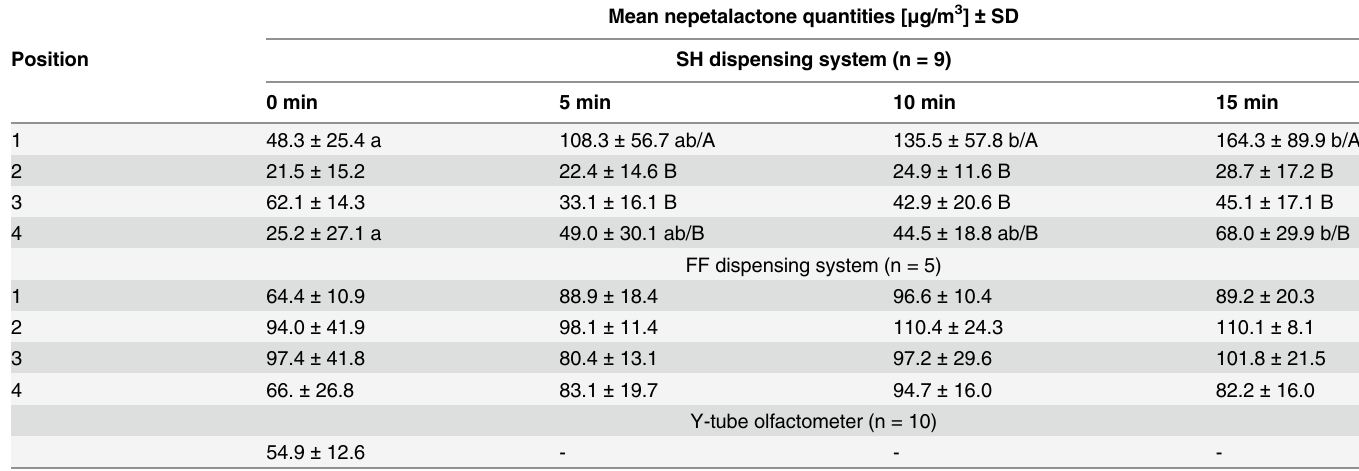
Table 1. Concentration of nepetalactone (mean ± SD) as determined in the air curtains of two dispensing systems and y-tube olfactometer by ther- mal desorption headspace gas chromatography-mass spectrometry (TD-GC-MS). Mean nepetalactone quantities [ μ g/m 3 ] ± Position